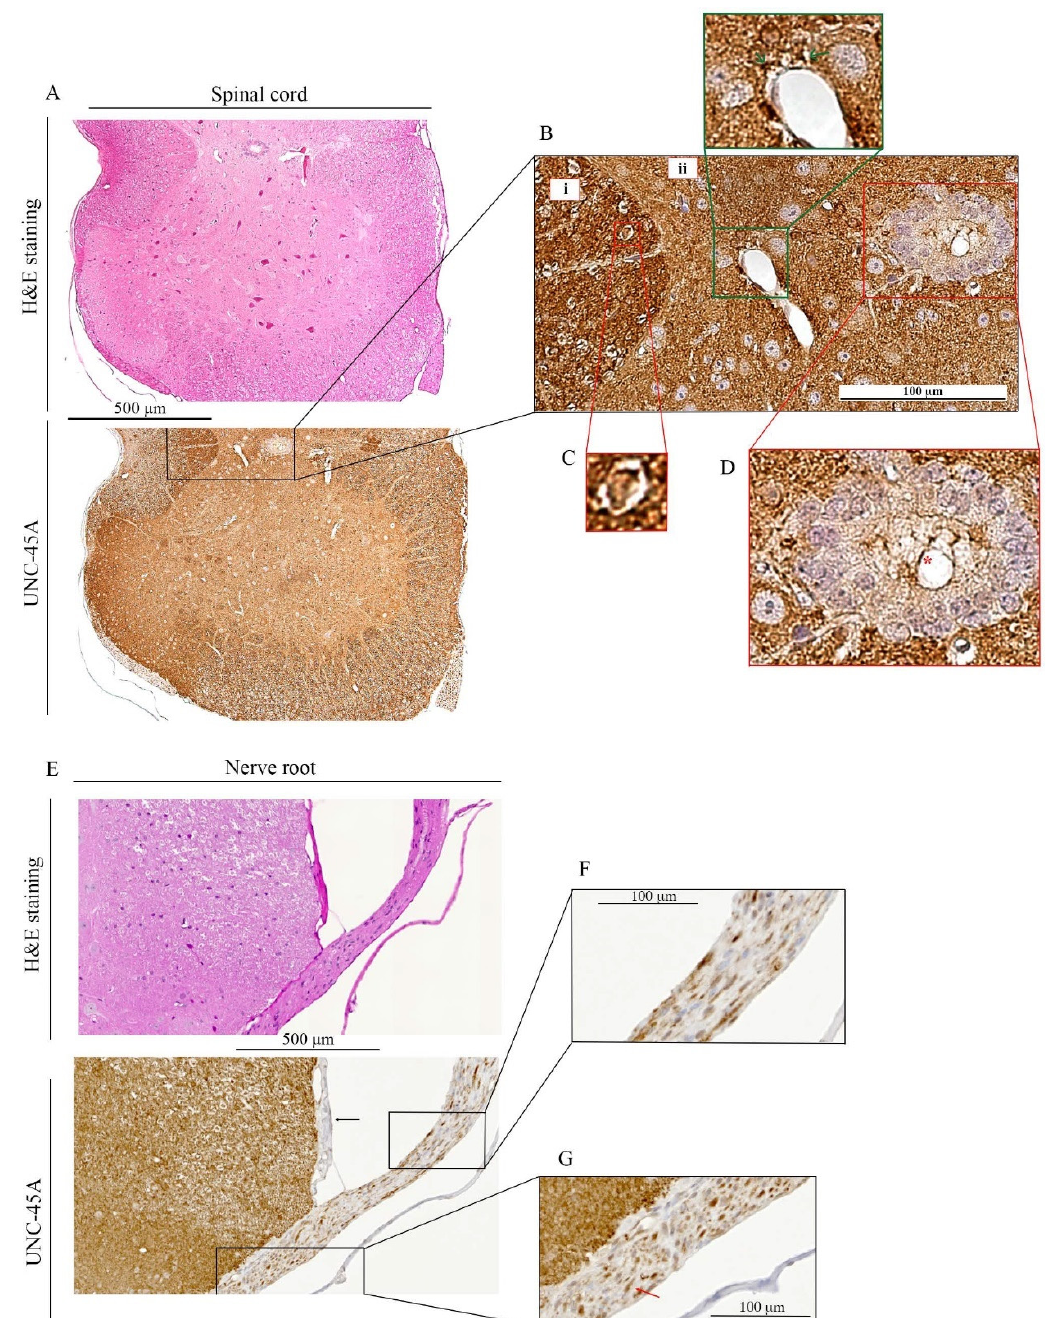
Figure 5. UNC-45A expression in mouse spinal cord and nerve root. ( A ). H&E (upper panel) and UNC-45A (lower panel) staining of the mouse spinal cord. ( B ). Details of UNC-45A staining in white matter (i), grey matter (ii), perivascular area (green arrow). ( C ). Detail of UNC-45A staining of a single cross-sectioned axon with its myelin coat. ( D ). UNC-45A staining in ependymocytes and their ciliary structures (red asterisk). ( E ). H&E (upper panel) and UNC-45A (lower panel) staining of the mouse nerve root (black arrow indicates the meninge). ( F ). UNC-45A staining in the longitudinal section of the nerve root. ( G ) . UNC-45A staining in cross-section of the nerve root (red arrow indicates the myelin sheath).